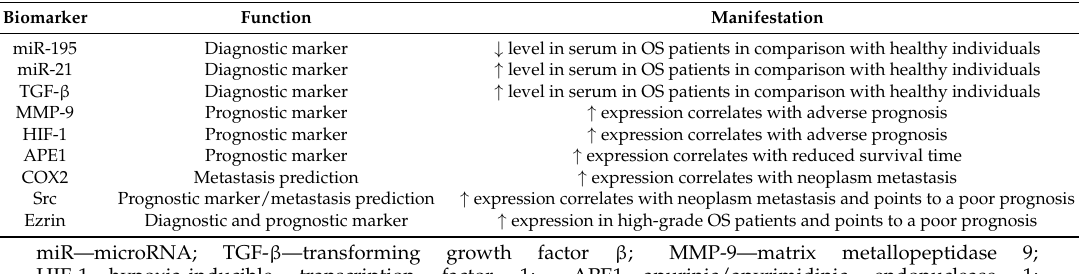
Table 2. Overview of promising biomarkers in